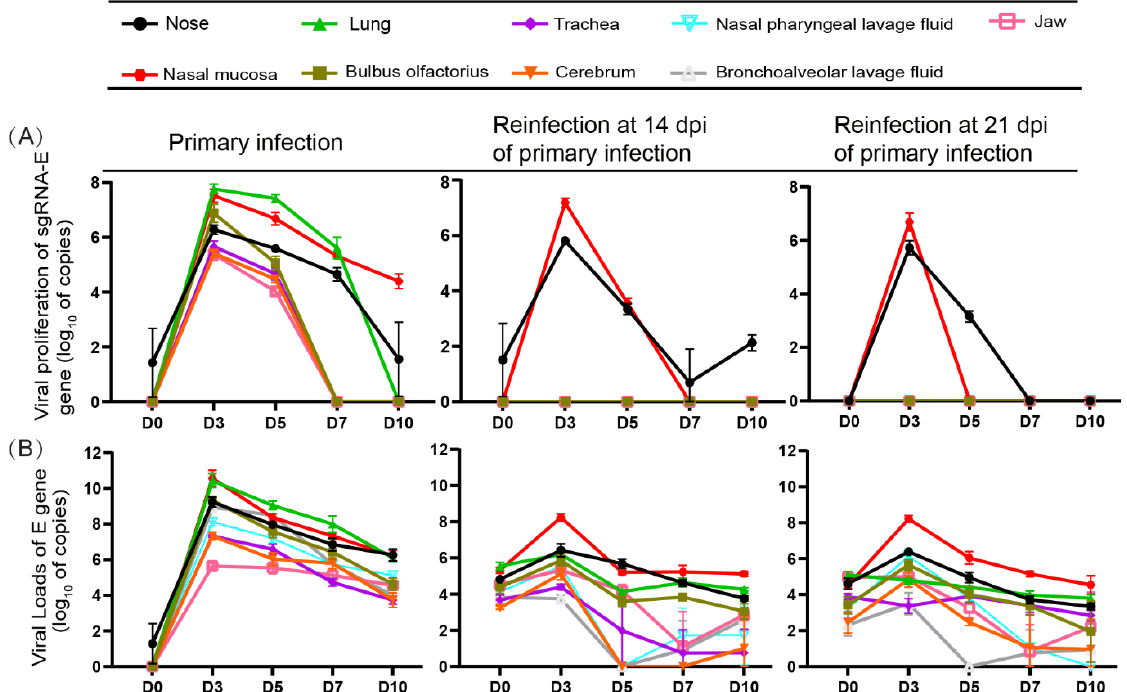
Figure 2. Obvious viral replication was observed in the upper respiratory tract during reinfection, while no viral replication was observed in the lower respiratory tract. ( A ) The levels of the sgRNA-E gene were detected in 1 g of the nose, nasal mucosa, lung, trachea, bulbus olfactorius, cerebrum, and jaw, which represent the areas of viral replication. n = 3. ( B ) The levels of the virus load-E gene were detected in 1 g of the nose, nasal mucosa, lung and trachea, bulbus olfactorius, cerebrum, jaw, nasal pharyngeal lavage fluid, and bronchoalveolar lavage fluid. n = 3. The levels are shown as log 10 of